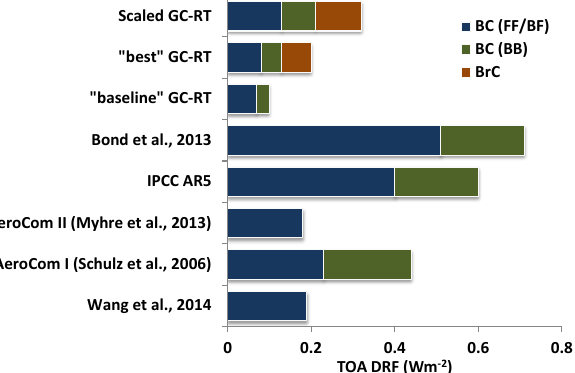
Figure 11. Comparison of our GC-RT estimate of global average DRF of BC compared to other studies. DRF is show by source type (FF = fossil fuel, BF = biofuel, BB = biomass burning). We also show the absorption DRF from BrC.